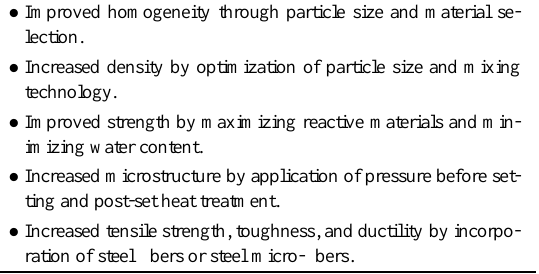
Principles of RPC and